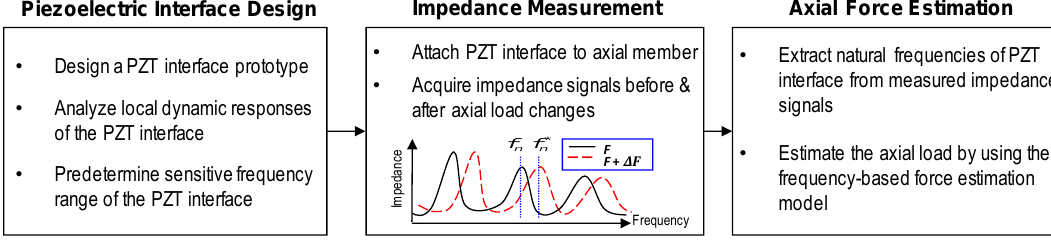
Figure 1. Axial force estimation method using impedance measurement.